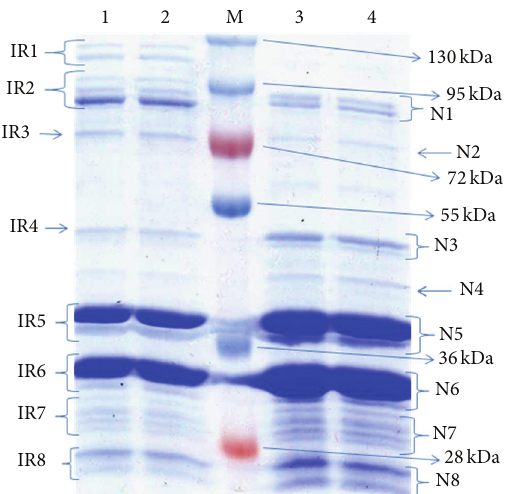
Figure 1: Coomassie blue-stained SDS-PAGE showing outer mem- brane protein profile of Pasteurella multocida serotype B:2 (P52) strain cultured in iron-rich or iron-limited media. Lanes 1, 2: OMPs growing in iron limiting condition, lane M: prestained protein ladder, and lanes 3, 4: OMPs growing in iron-rich condition. IR: bacteria grown under iron-regulated condition; N: bacteria grown under normal condition (iron-rich condition). IR-1 to IR-8 and N1 to N8 represent the portion of the gel slice cut and sent for MALDI- TOF/MS analysis. The proteins identified in the MASCOT analysis are presented in Table